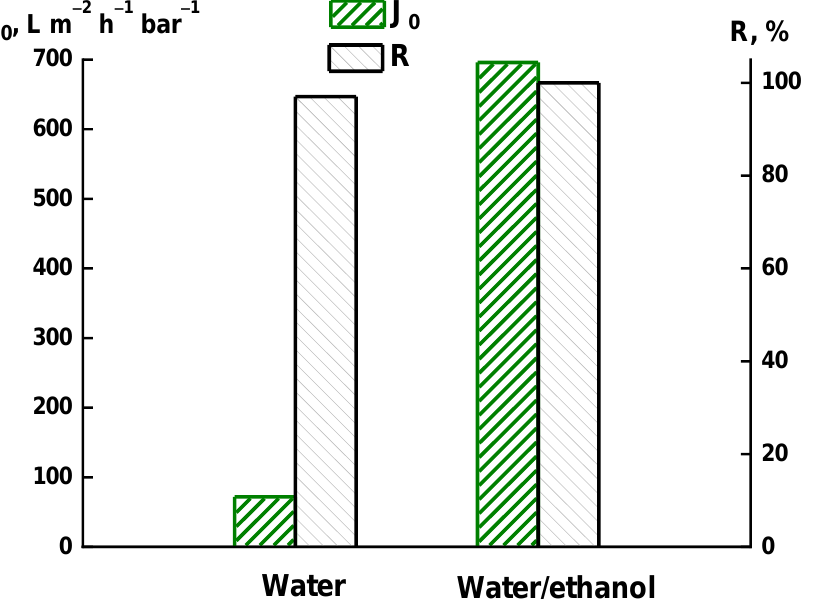
Figure 2. Dependence of pure water flux ( J 0 ) and BSA rejection ( R ) on the composition of coagulation bath.